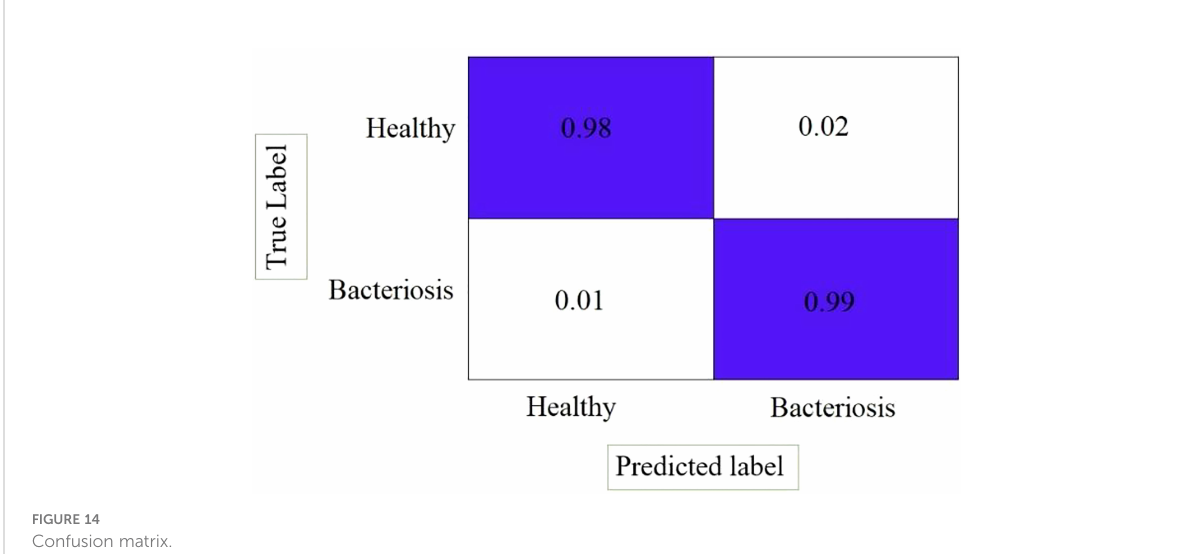
FIGURE 14 Confusion matrix.